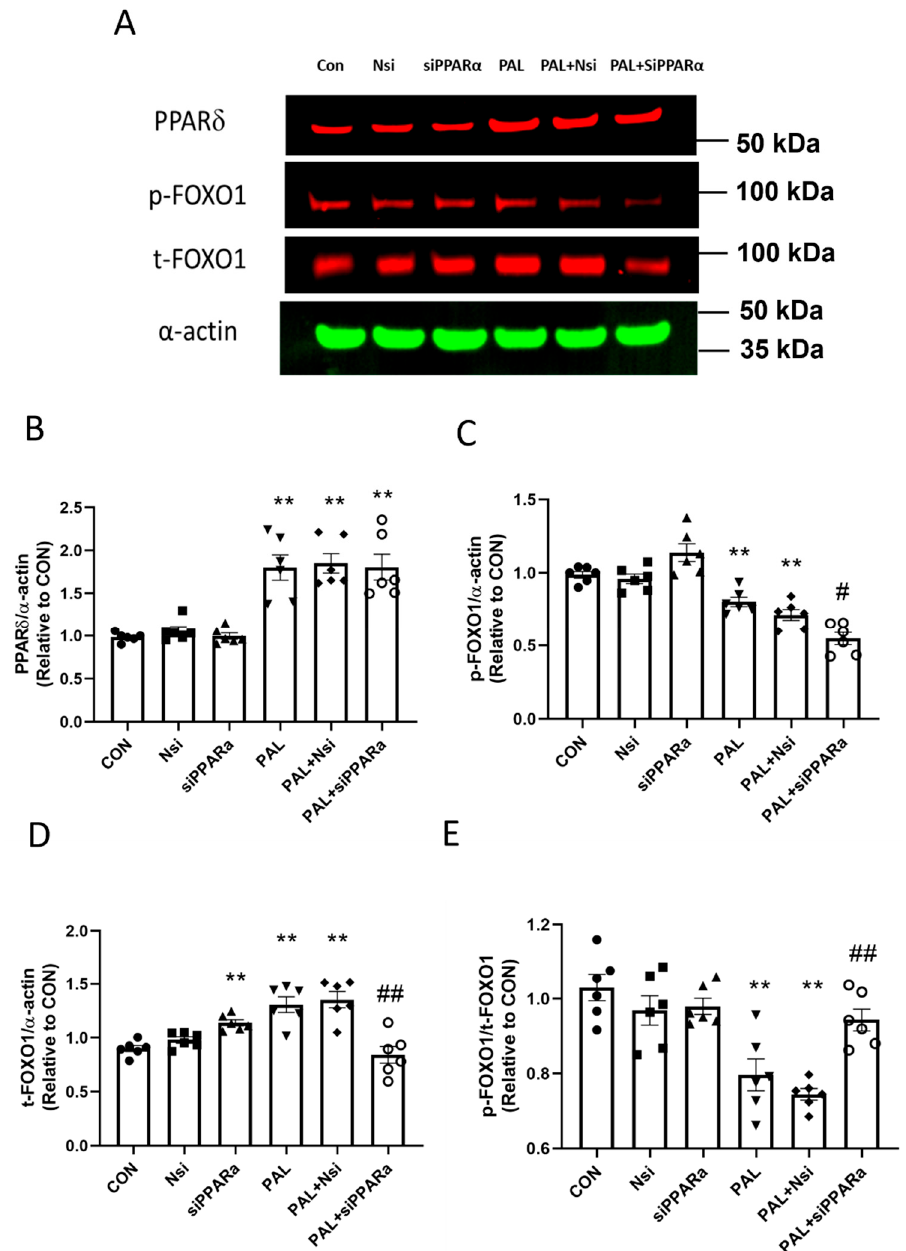
Figure 6. PPAR δ ( A , B ) and FOXO1 ( A , C , D , E ) protein expression in C2C12 myotubes af- ter PPAR α siRNA gene silencing in the absence ( left panels ) or presence of palmitate (PAL; right panels ). Significantly different from control without PAL (CON, ** p < 0.01). Signifi- cantly different from CON + PAL ( # p < 0.05; ## p < 0.01). Data represent mean ± SEM of 6 individual experiments for each intervention group. Nsi—silencer negative